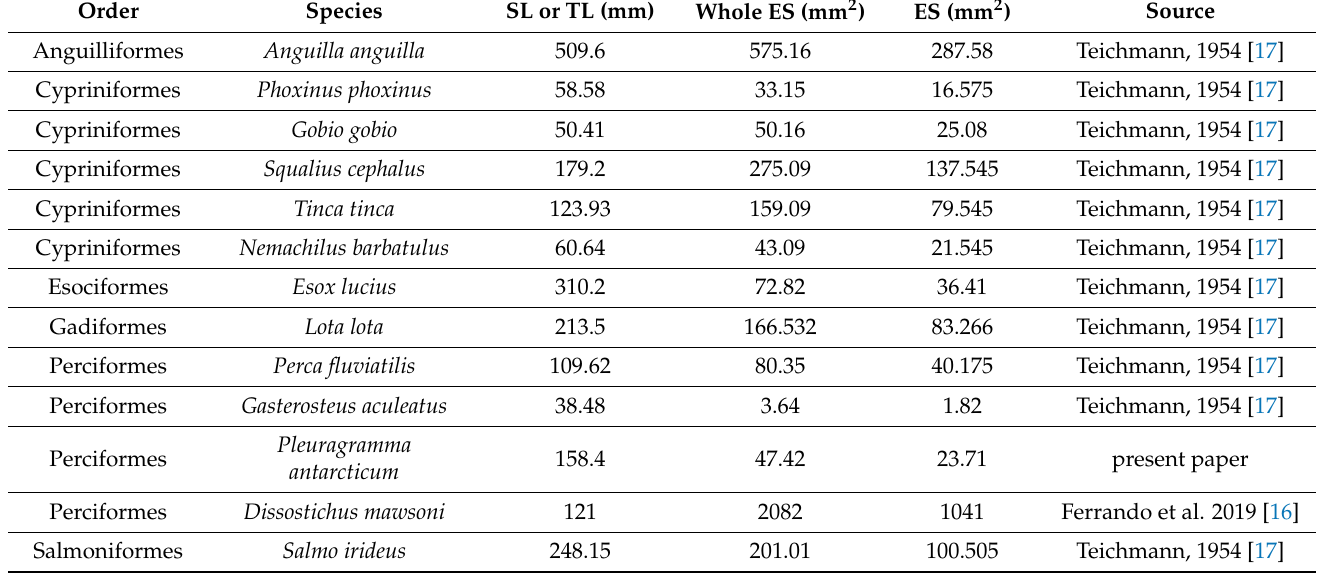
Table 1. Measurements and counts for 13 species of teleost fish from the present study and from the literature. SL = standard length; TL = total length; the body size reported in the table is SL for all the species—except D. mawsoni, for which the total length is indicated. Whole ES = epithelial surface area for two olfactory organs—that is, the whole surface of the fish; ES = epithelial surface area of one olfactory